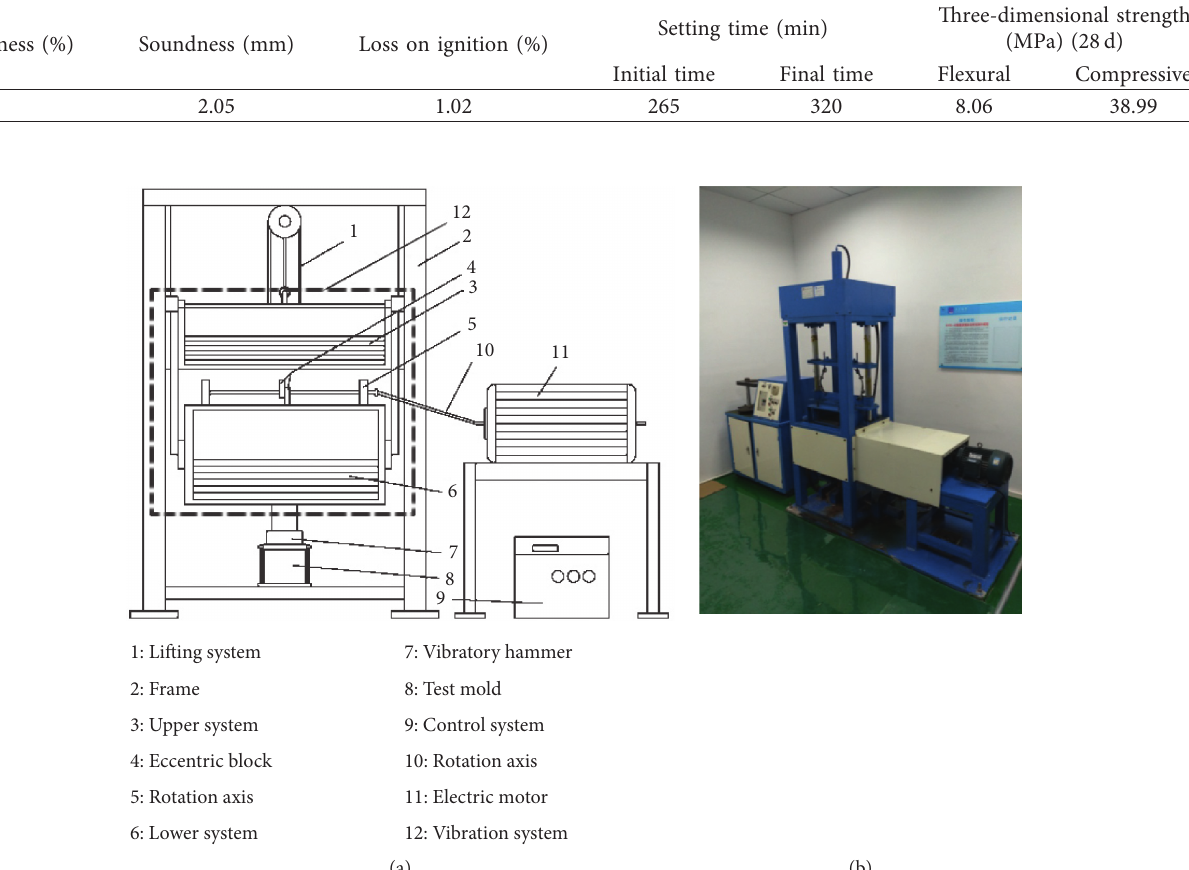
Table 2: Technical properties of cement.